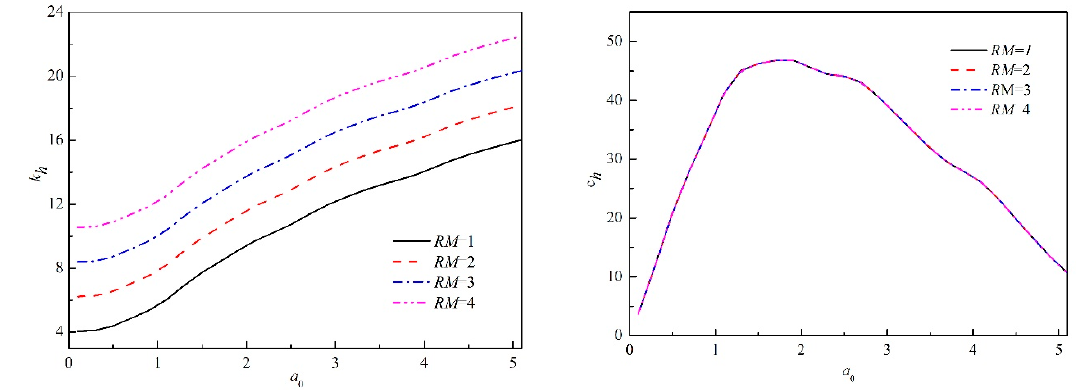
Figure 6. Horizontal dynamic impedance of embedded foundation under different mass ratio.